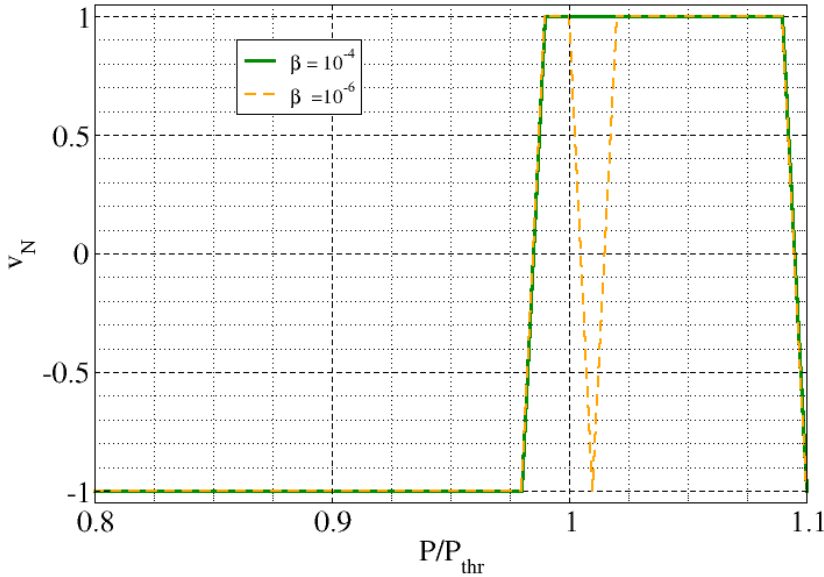
Figure 9. Comparison of the population inversion component v N (matching the µ component of the perturbation in the lsa , Equations (14) and (15)) of the least stable eigenvector (matching the least stable eigenvalue in Figure 4) for a micro- ( β = 10 − 4 ) and a macroscopic laser ( β = 10 − 6 ). The closeness of the modulus of this component to 1 (i.e., nearly the entire normalized eigenvector’s amplitude) is clearly visible over the whole pump range. As in Figure 7, each curve stops at the point where the eigenvector becomes complex, simultaneously with the appearance of an imaginary component in the corresponding eigenvalue. The sudden switches between negative and positive unity represent a sudden rotation in the